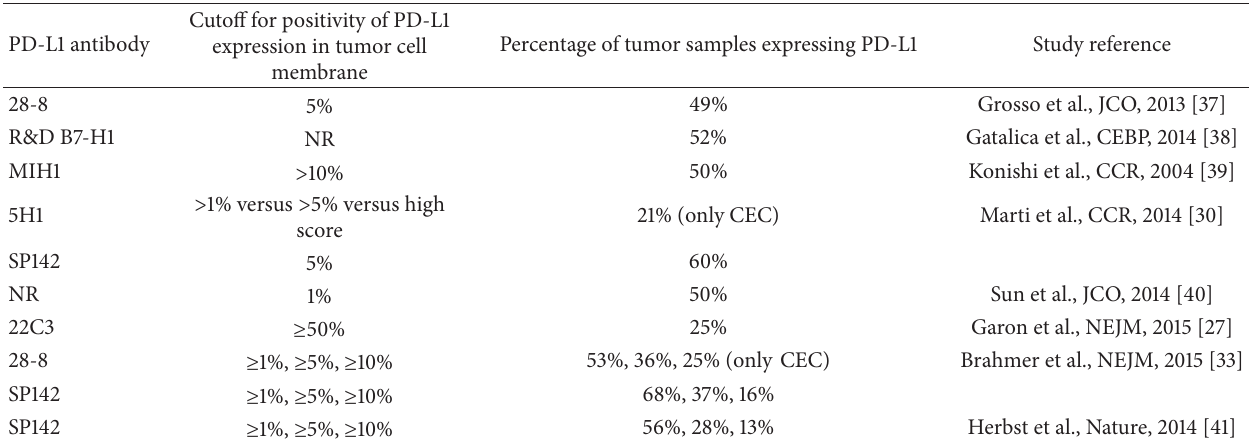
Table 12: Immunohistochemistry for PD-L1 in clinical